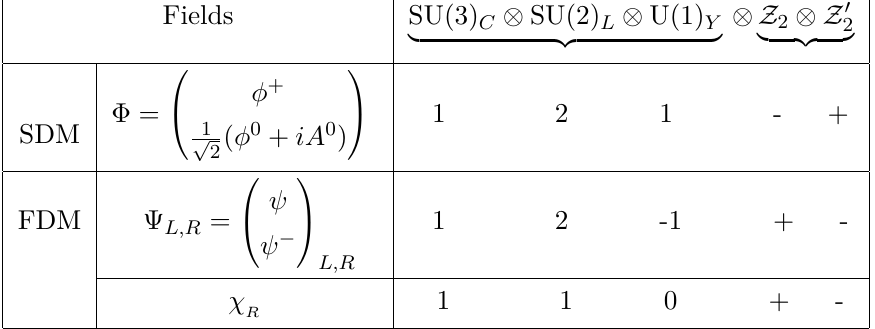
SU(3) SU(2) U(1) and G SM ≡ C ⊗ L ⊗ Y DM ≡ Z 2 ⊗ Z